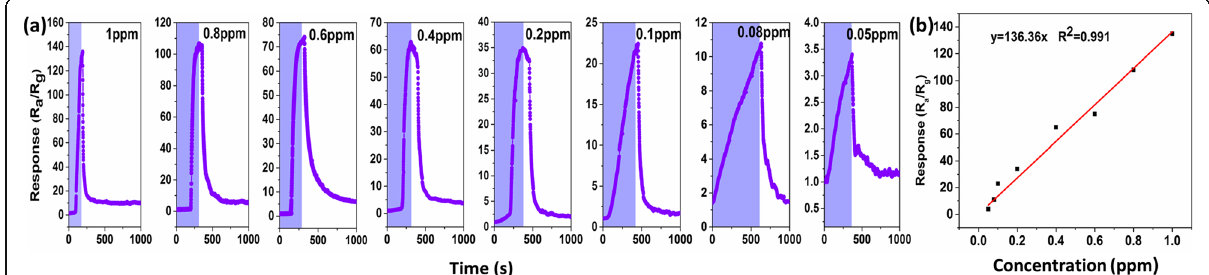
Fig. 10 a , b Real-time response – recovery characteristic curve of the 5%Ag-In 2 O 3 toward formaldehyde at different concentrations (1, 0.8, 0.6, 0.4, 0.2, 0.1, 0.08, 0.05 ppm) at 30